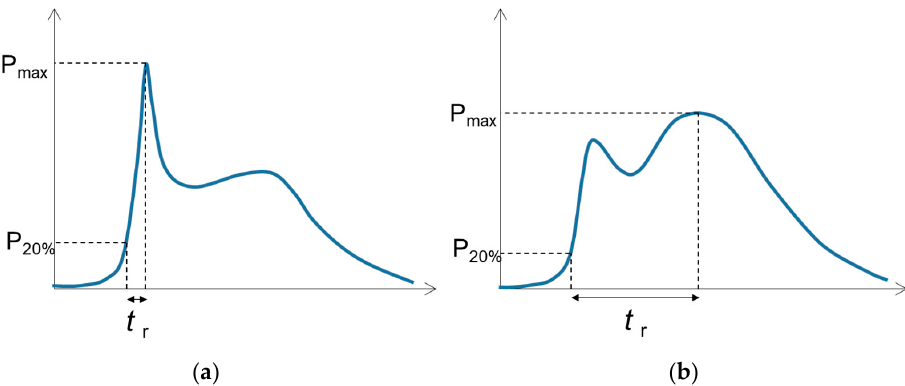
Figure 3. Definition of pressure rise time (cid:1872) (cid:3045) . ( a ) Impulse-dominant and ( b ) Surge-dominant pres- sures.